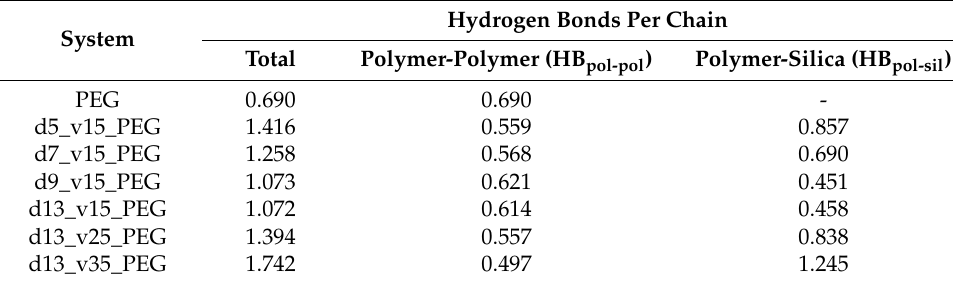
Table 4. MD simulation predictions for the number of hydrogen bonds formed in the simulated PEG-silica nanocomposites per PEG chain present in the melt ( T = 413 K and p = 1 atm). For the nanocomposites, separate results are reported for HB pol-pol and HB pol-sil .